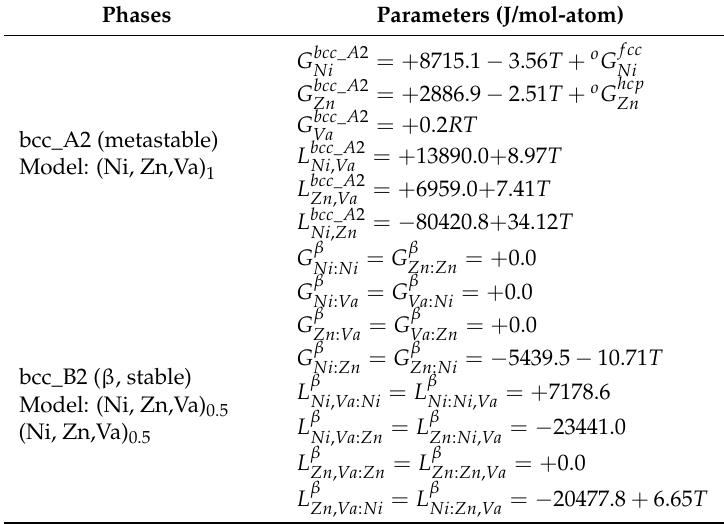
Table 1. Summary of the optimized parameters for bcc_A2 and β phase in Ni-Zn binary